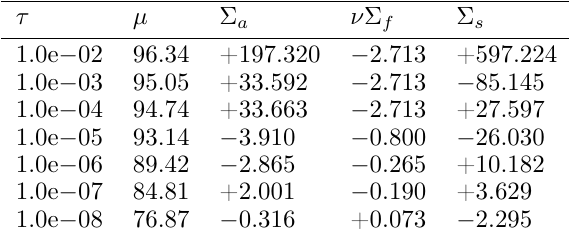
Table 8. Error on macroscopic cross sections after lossy compression by truncated HT on the UGd dataset with separate matrices M per nuclide and